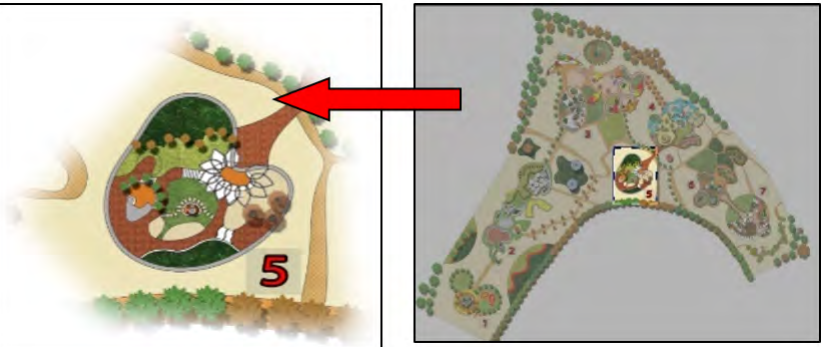
Figure 20. The location of “Bird Area” zone